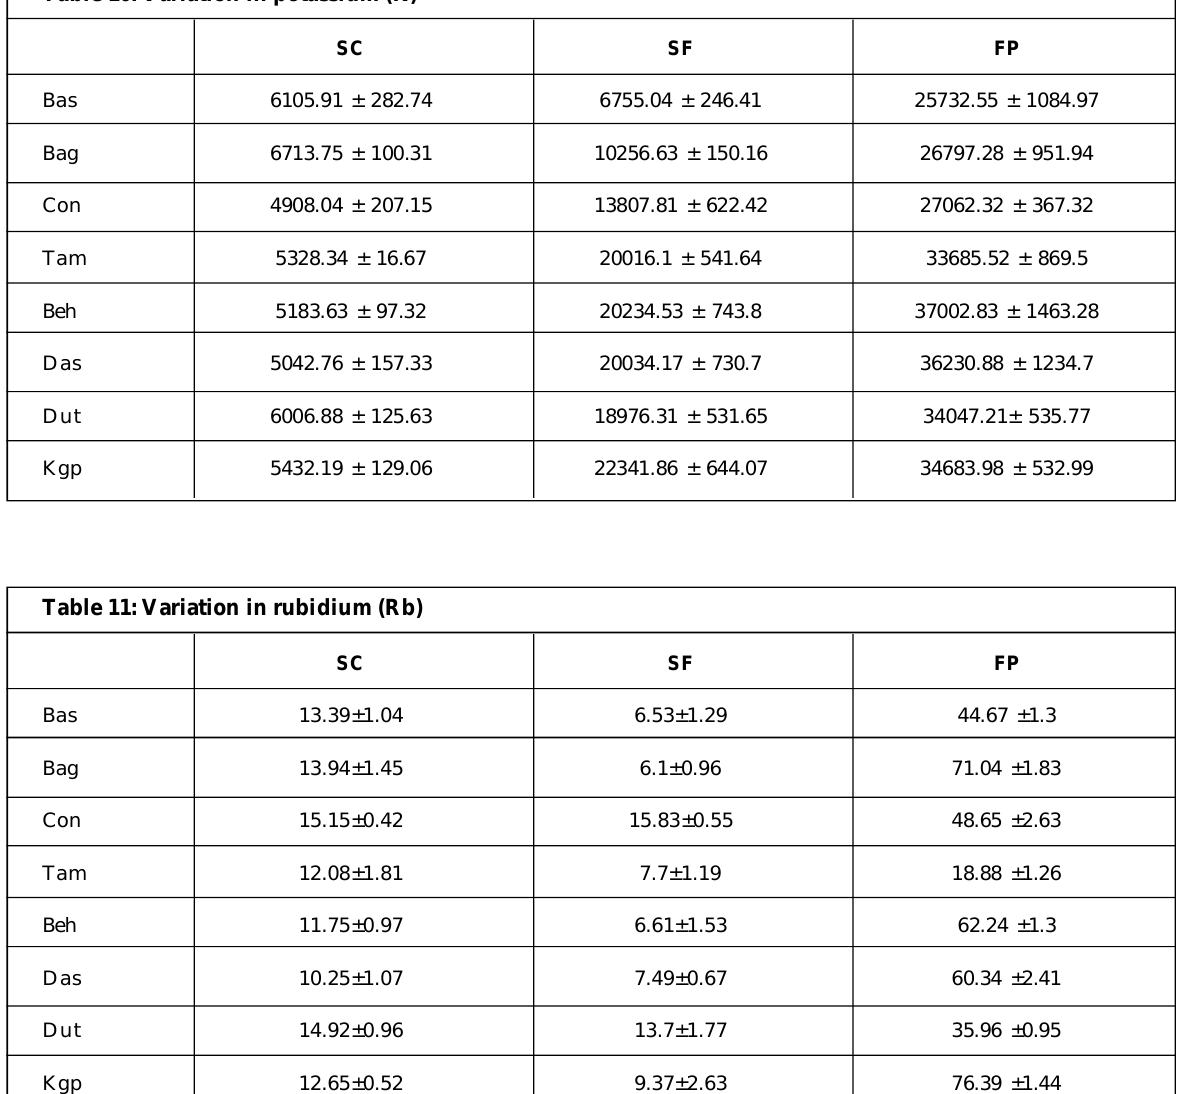
Table 10: Variation in potassium (K)